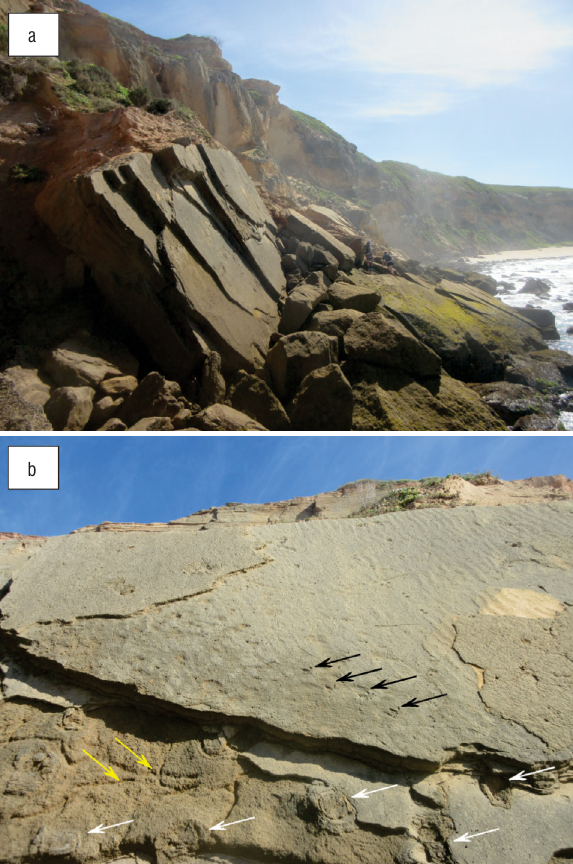
Figure 5: The newly exposed large rock that is situated adjacent to the Roberts Rock site. (a) Eight bedding planes are exposed. (b) Yellow arrows indicate probable golden mole burrow traces; black arrows indicate avian tracks; white arrows indicate elephant